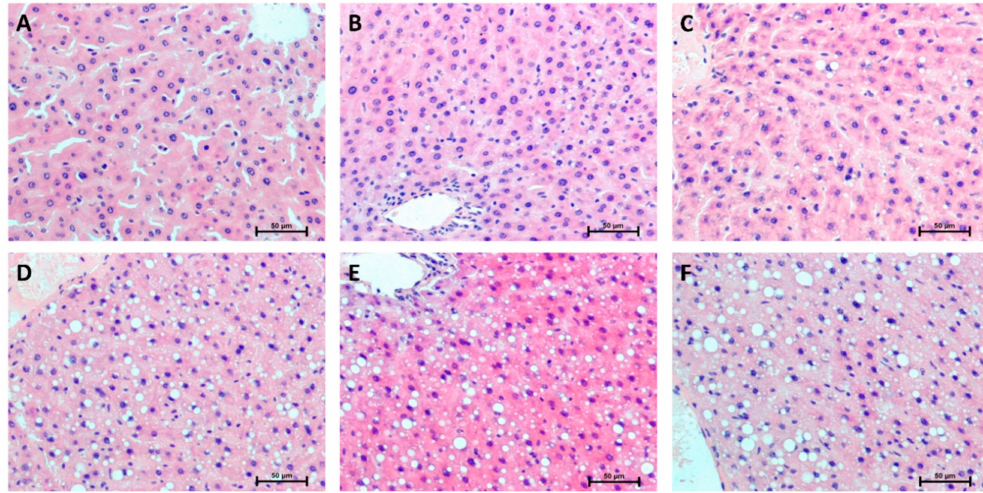
Figure 8. Representative histological images showing hematoxylin–eosin (H + E) staining of the liver from control group (0 week, A ) and HFD group at the end of the first ( B ), second ( C ), third ( D ), fourth ( E ) and fifth ( F ) experimental week. The data are based on six independent determinations ( n = 6) of the same fragment of the lobe from each rat. Original magnification of 200 × and the length of the calibration bar is 50 µ